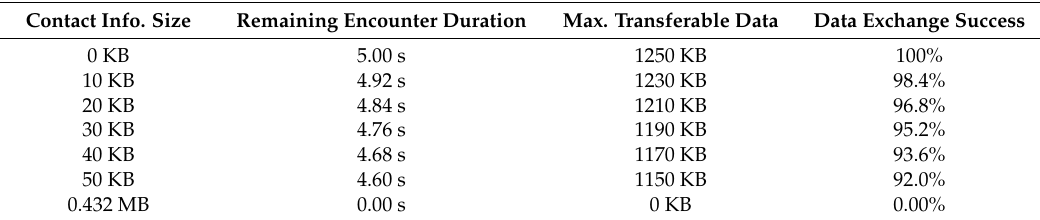
Table 1. Data exchange success for different amounts of contact information. Contact Info.